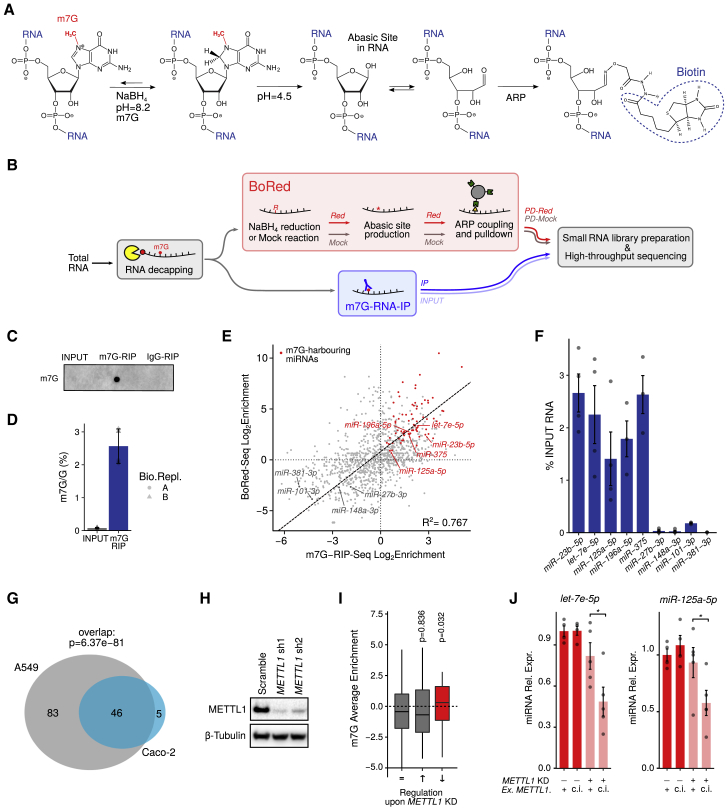
Detection of m7G in Specific miRNAs in A549 Cells(A) Schematic of a novel chemical method to detect internal m7G RNA modification.(B) Schematic representation of the procedure used to identify the m7G modified miRNAs in A549 cells.(C) Immuno-dot blot of total decapped INPUT RNA (10%) or RNA immunoprecipitated with anti-m7G antibody or control immunoglobulin G (IgG).(D) Immunoprecipitation with anti-m7G antibody enriches for m7G-containaing RNAs as determined by mass spectrometry (MS; see also Figure S1). The average of two biological replicates ± SDs is shown.(E) Scatterplot showing a high degree of consistency between the BoRed-seq approach and RIP-seq in detecting miRNAs harboring m7G (upper right quadrant). Goodness of fit is calculated as R2 Pearson correlation coefficient.(F) RNA immunoprecipitation with the anti-m7G antibody coupled to qRT-PCR was used to validate five m7G-containing miRNAs and four negative miRNAs, which are identified in (E). The average of four biological replicates ± SDs is shown. The distributions of mean enrichments in m7G+ and m7G− miRNAs are significantly different, as evaluated by the two-tailed Wilcoxon text (∗p < 0.05).(G) Venn diagram showing the overlap between miRNAs significantly enriched in m7G-RIP of A549 and Caco-2 cells, respectively (see also Figure S2). The p value is obtained by Fisher’s exact test.(H) Western blot showing METTL1 protein levels in A549 cells infected with METTL1-specific (sh1, sh2) or control (Scramble) tetracycline (TET)-inducible shRNAs 5 days after doxycycline treatment. A representative experiment of four independent biological replicates is shown.(I) Boxplot showing increased m7G signal (as an average enrichment in both BoRed-seq and m7G-RIP-seq; E) in miRNAs that are significantly downregulated (↓) upon inducible METTL1 knockdown, but not in miRNAs that are unchanged (=) or upregulated (↑). Statistical significance was calculated by the Wilcoxon test.(J) qRT-PCR showing the levels of let-7e-5p and miR-125a-5p in WT and METTL1 knockdown A549 cells in the presence of either active (+) or catalytically inactive (c.i.) exogenous METTL1 (Ex. METTL1).